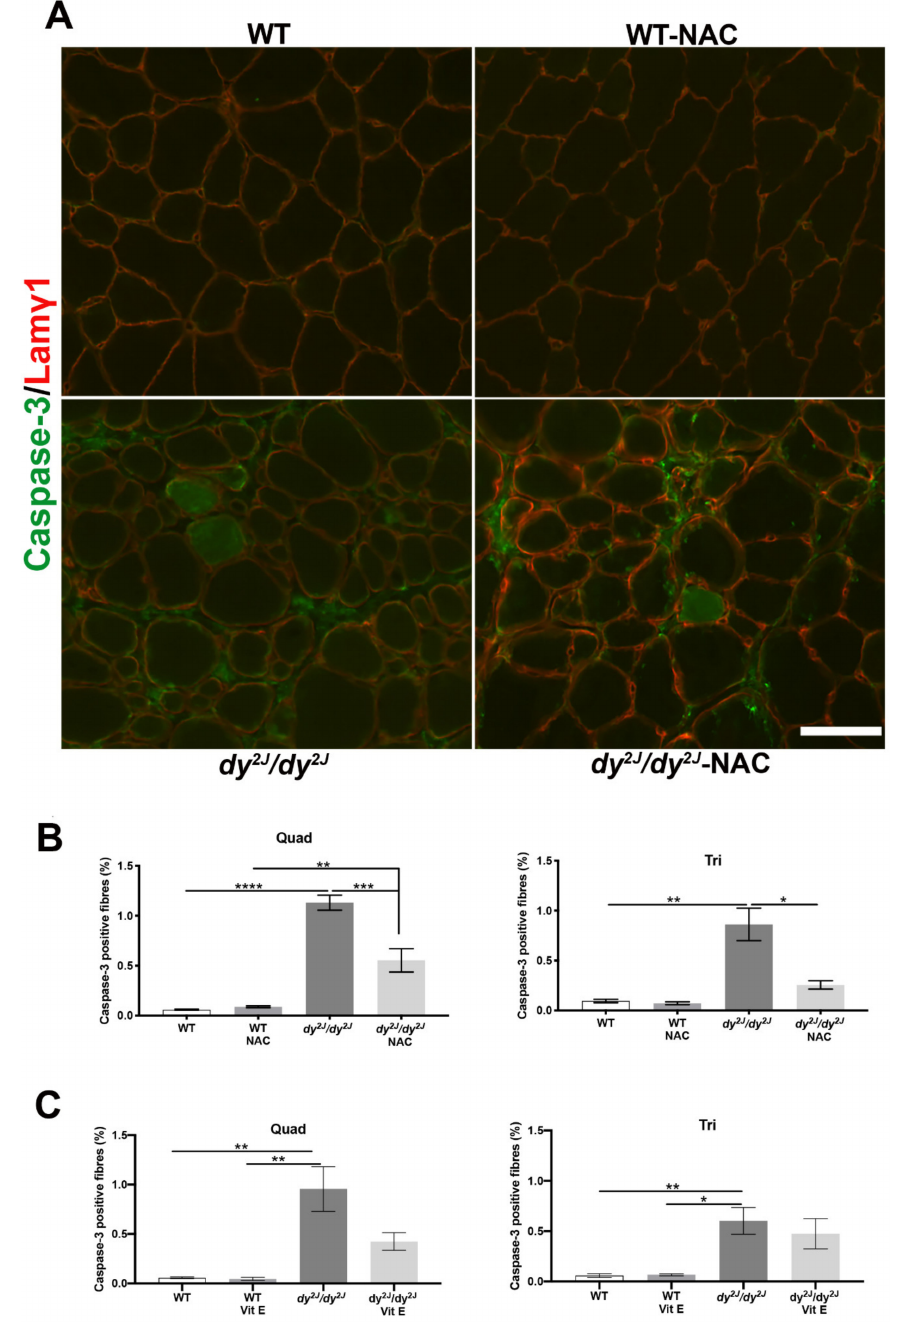
Figure 7. ( A ) Representative caspase-3-stained quadriceps muscle sections; ( B ) The number of myofibers positively stained for caspase-3 (green color) in 5 WT, 6 WT NAC, 7 dy 2J / dy 2J , 5 dy 2J / dy 2J NAC quadriceps and 5 WT, 5 WT NAC, 9 dy 2J / dy 2J and 5 dy 2J / dy 2J NAC triceps muscles; ( C ) The number of muscle fibers positively stained with caspase-3 (green color) in 5 WT, 4 WT vit E, 5 dy 2J / dy 2J , 4 dy 2J / dy 2J vit E quadriceps and 5 WT, 4 WT vit E, 5 dy 2J / dy 2J and 4 dy 2J / dy 2J vit E triceps muscles. * p < 0.05, ** p < 0.01, *** p < 0.001 and **** p < 0.0001. Bar: 50 µ